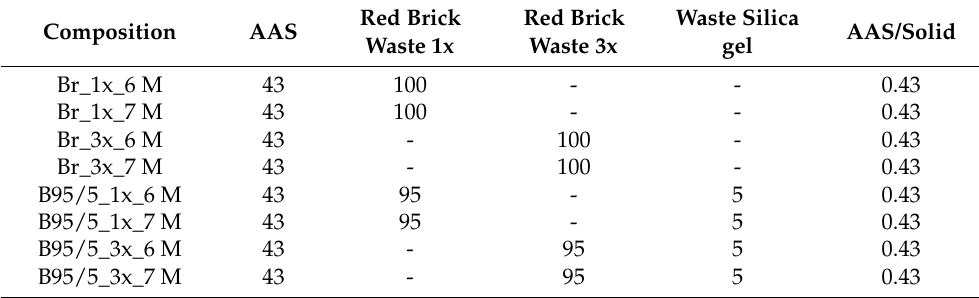
Table 3. AAM with red brick waste precursor with different fineness activated with 6 or 7 M NaOH and with silica gel addition,